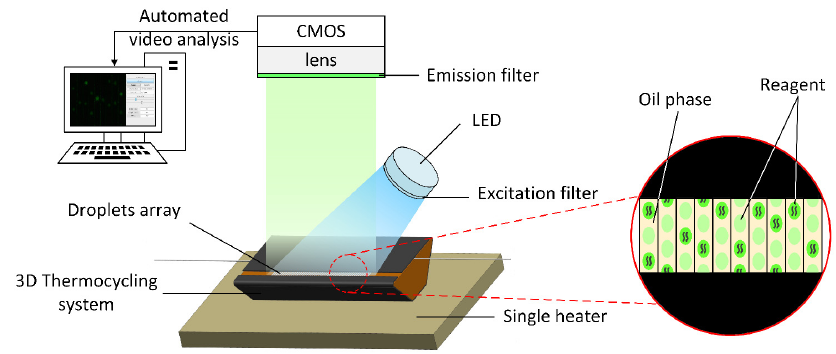
Figure 2. Structure of a miniaturized continuous-flow digital PCR fluorescence detection system.